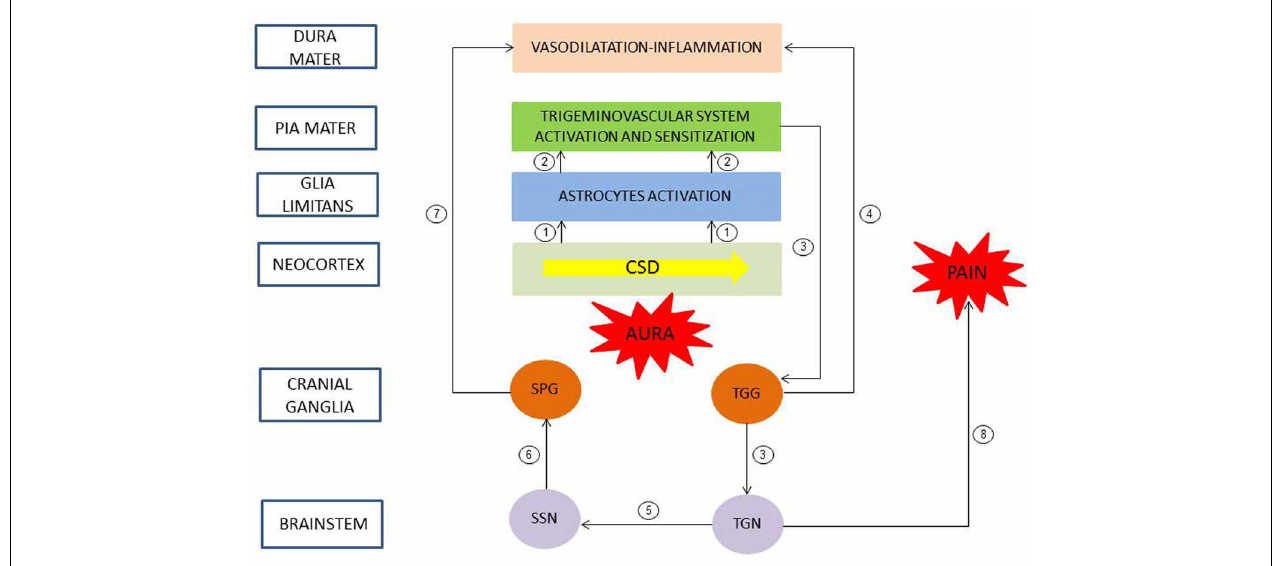
FIGURE 1 | Pathophysiology of migraine with aura. A slow wave of neuronal and glial depolarization, cortical spreading depression (CSD), has been implicated in the mechanism of migraine aura. Moreover, CSD induces an opening of stressed neuronal Panx1 channels with subsequent release of proinflammatory mediators. These mediators activated astrocytes of the glia limitans leading to a continuous release of cytokines, prostanoids and nitric oxide to subarachnoid space (1). These molecules diffuse locally and depolarize and sensitize perivascular trigeminal terminals in pia mater (2, peripheral sensitization). In turn, the caudal portion of the trigeminal nucleus